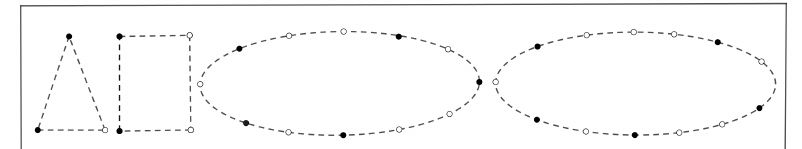
Figure 5. H 32 = B 3 + B 4 + B 12 + B 13 with its nr -set.